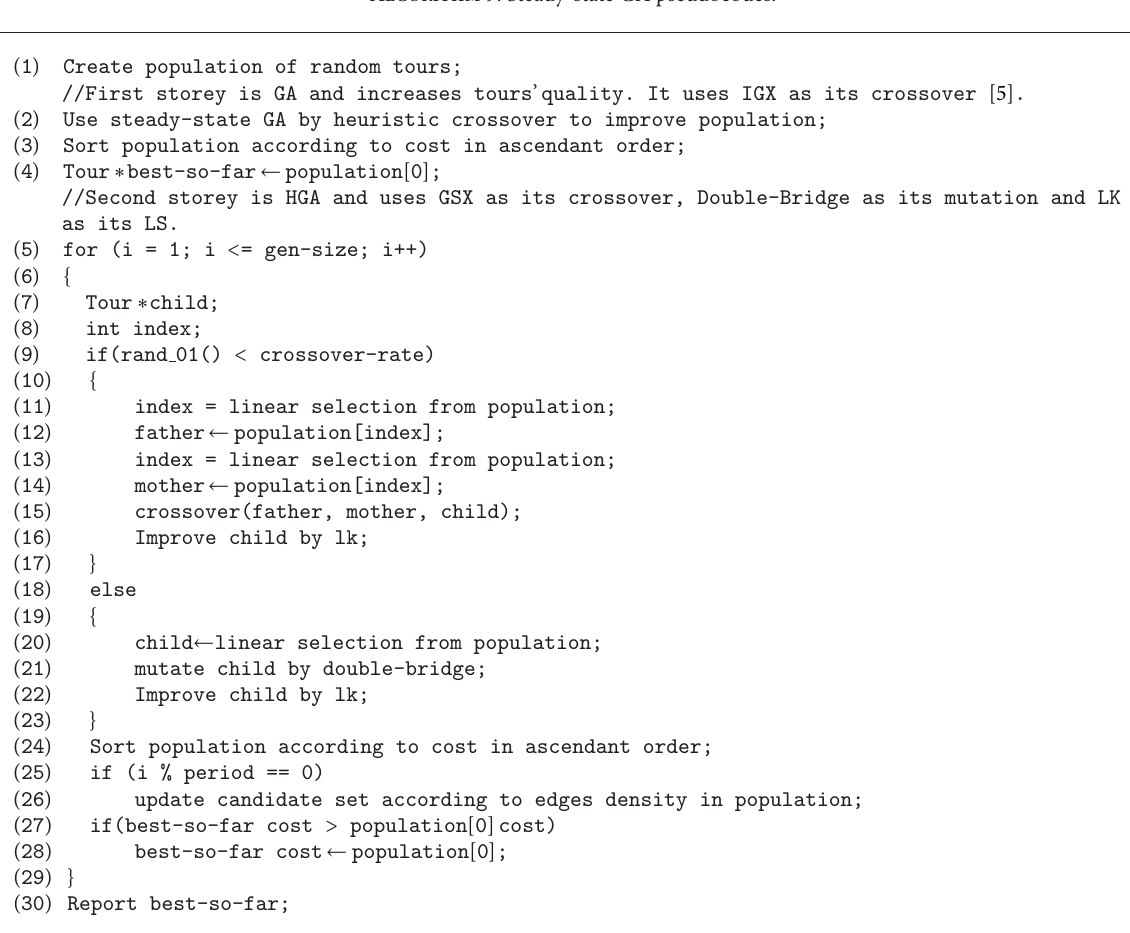
Algorithm 9: Steady-state GA pseudocodes.